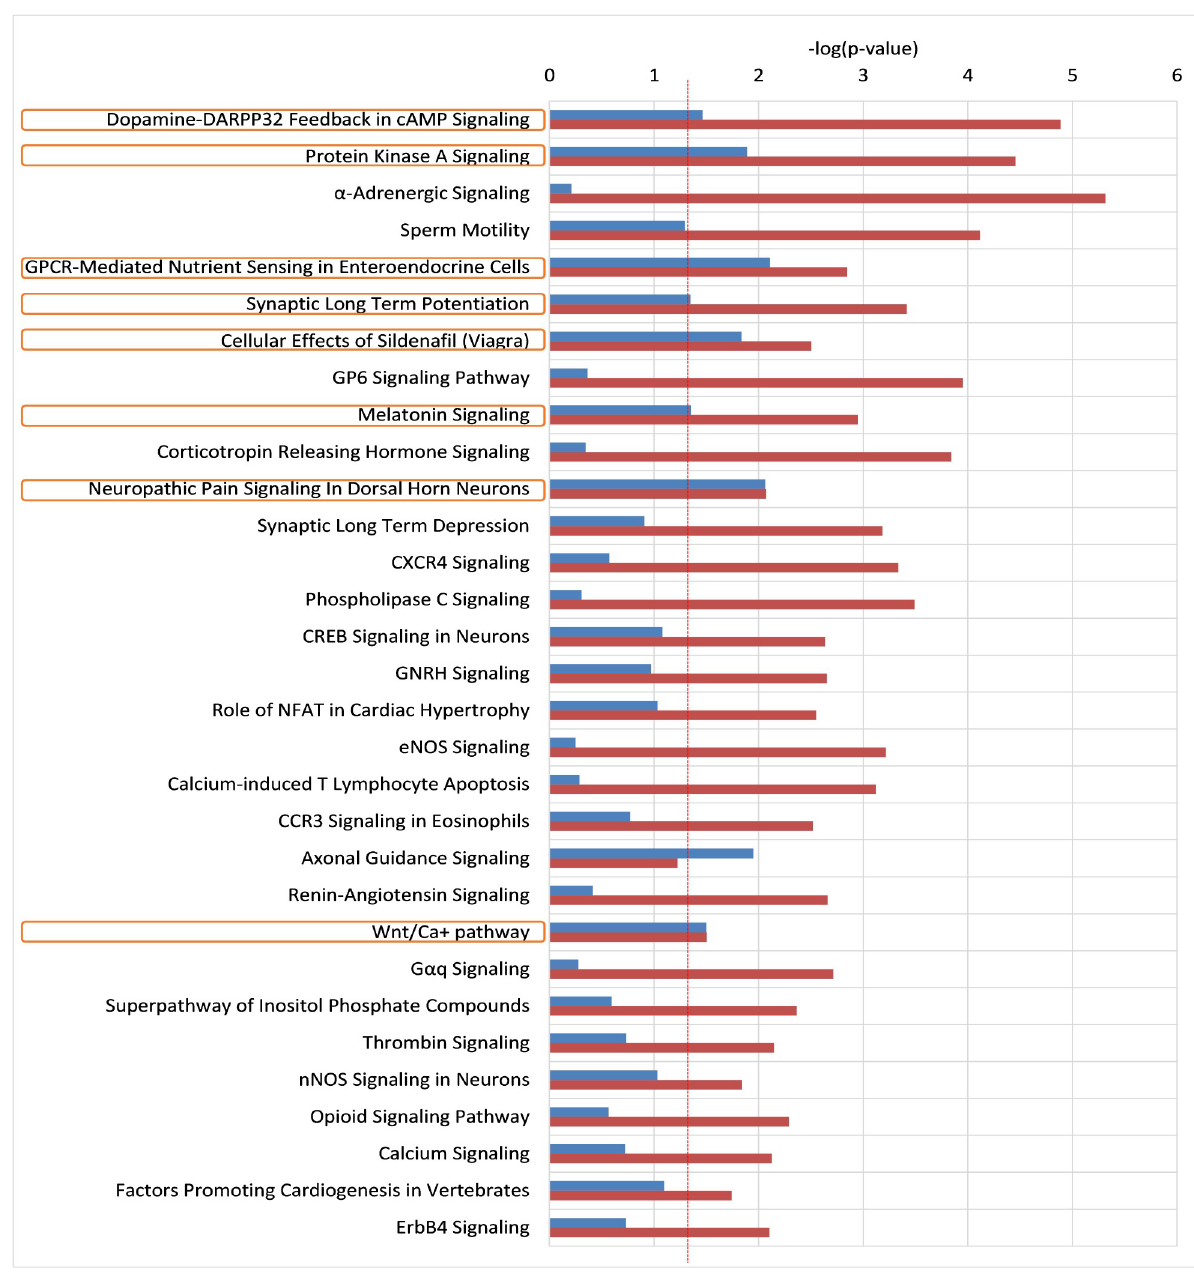
Fig 1. Results of the comparative gene ontology analysis. Eight pathways were shown to be significantly (p < 0.05) represented in the groups of SNPs derived from both studies, they are marked with orange boxes. Horizontal red line indicates the p = 0.05 significance level. Significance levels on a negative log scale are indicated with blue (Discovery sample) and red (Replication sample)